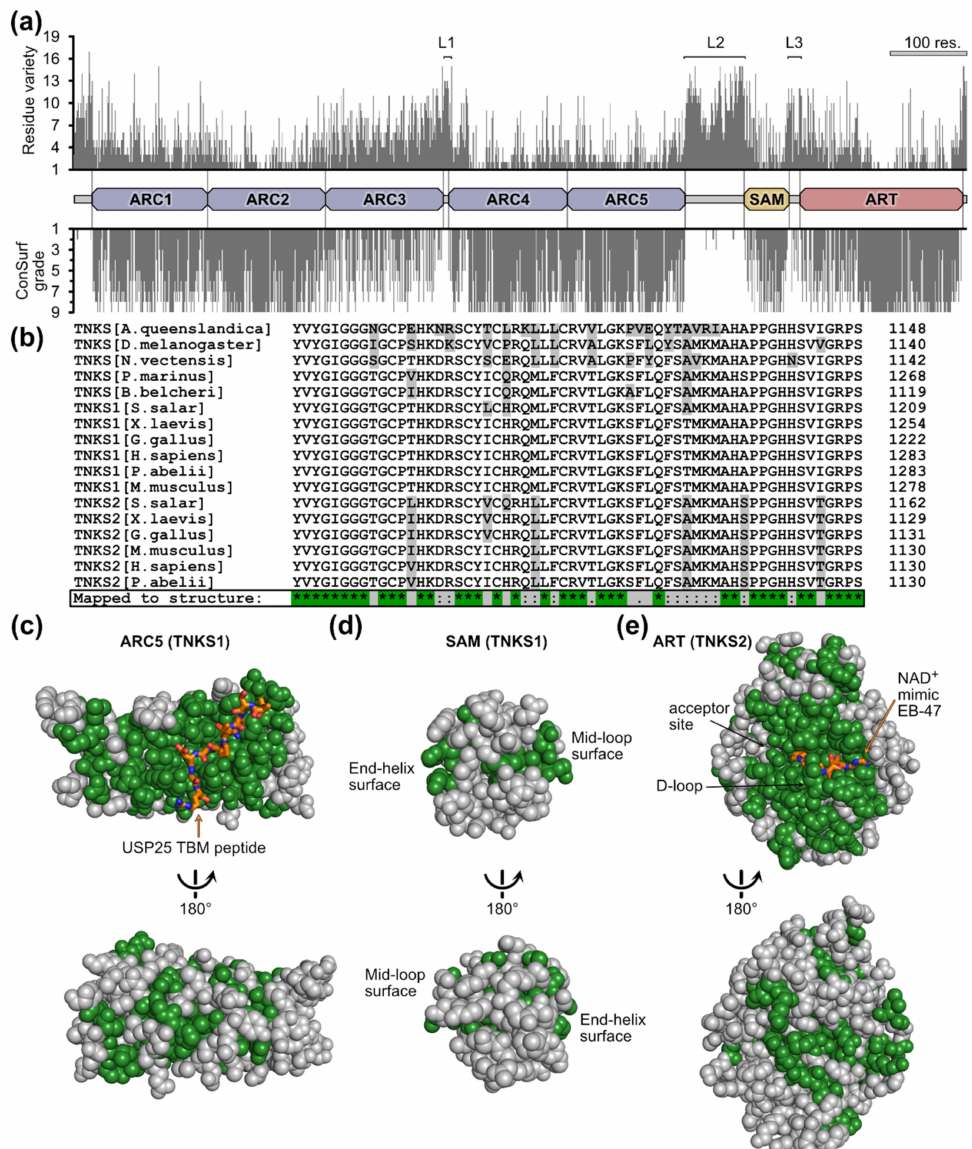
Figure 4. Conservation of tankyrase residues linked to the protein structure. ( a ) Residue-specific conservation plot. The number of different residue identities and ConSurf grade was plotted for each residue from an alignment of 113 TNKS sequences. The ConSurf grade is a normalized measure for the conservation and ranges from 1 (low conservation) to 9 (high conservation). The three likely flexible linker regions are designated L1, L2 and L3. The projected domain boundaries were assigned based on existing structural information of individual domains from human TNKS1 and TNKS2. A scale corresponding to 100 amino acid residues is shown. ( b ) A representative section of a multiple sequence alignment from the TNKS sequences of 11 metazoan species. This section covers a part of the ART domain sequence. Residues highlighted in gray are different compared to human TNKS1. Only residues identical in every TNKS sequence were mapped to the structures and are shown in green: ( c ) Structure of the ARC5 domain from human TNKS1 in complex with the TBM peptide from USP25 (orange) (PDB: 5GP7, [25]). ( d ) Structure of the SAM domain from human TNKS1 (PDB: 5KNI, [20]). ( e ) Structure of the ART domain from human TNKS2 in complex with the NAD + -mimicking compound EB-47 (orange) (PDB: 4BJ9,